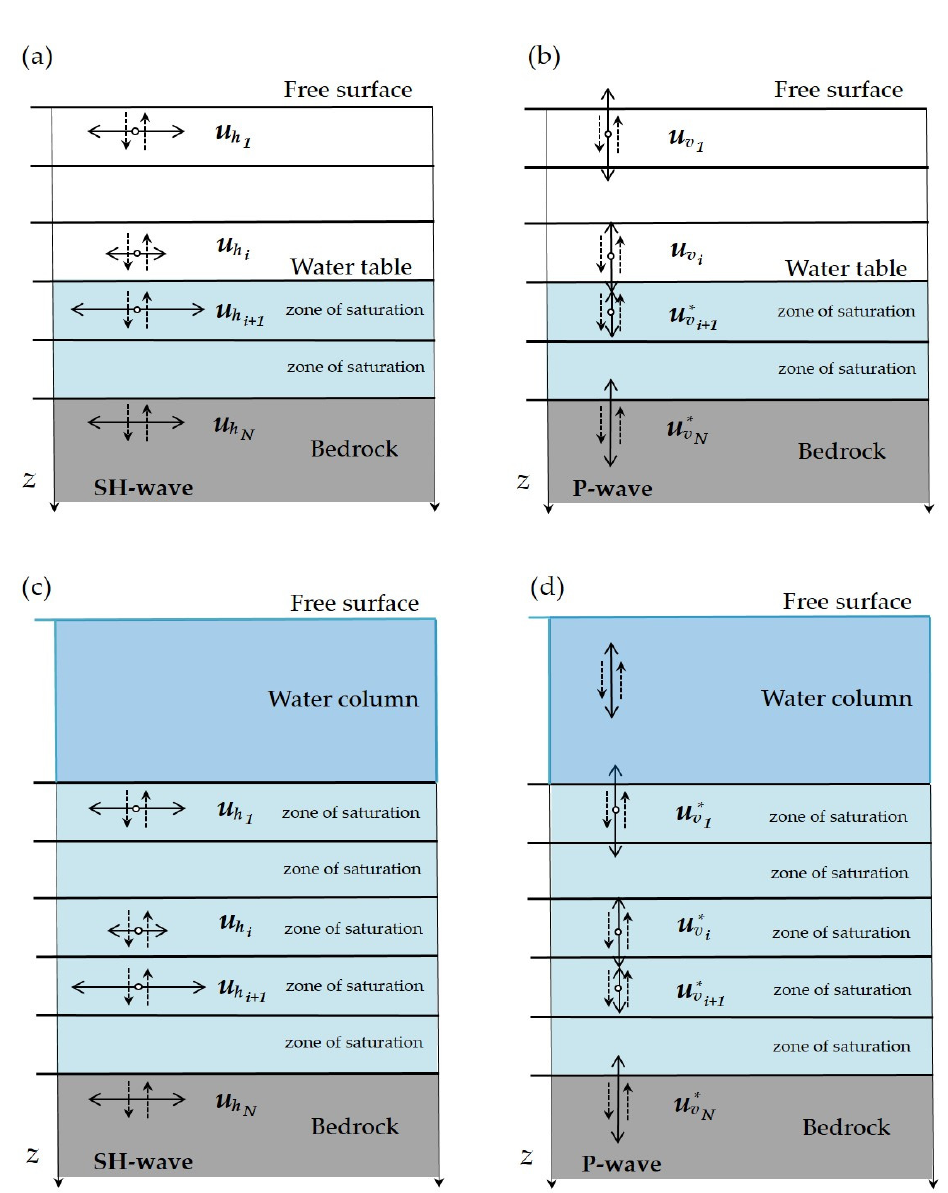
Figure 1. One-dimensional horizontally layered system of porous saturated soils and its spatial discretization in the case of vertically propagated waves: ( a ) a shear wave (on-land site), ( b ) a compression wave (on-land site), ( c ) a shear wave (site in water area), ( d ) a compression wave (site in water area).